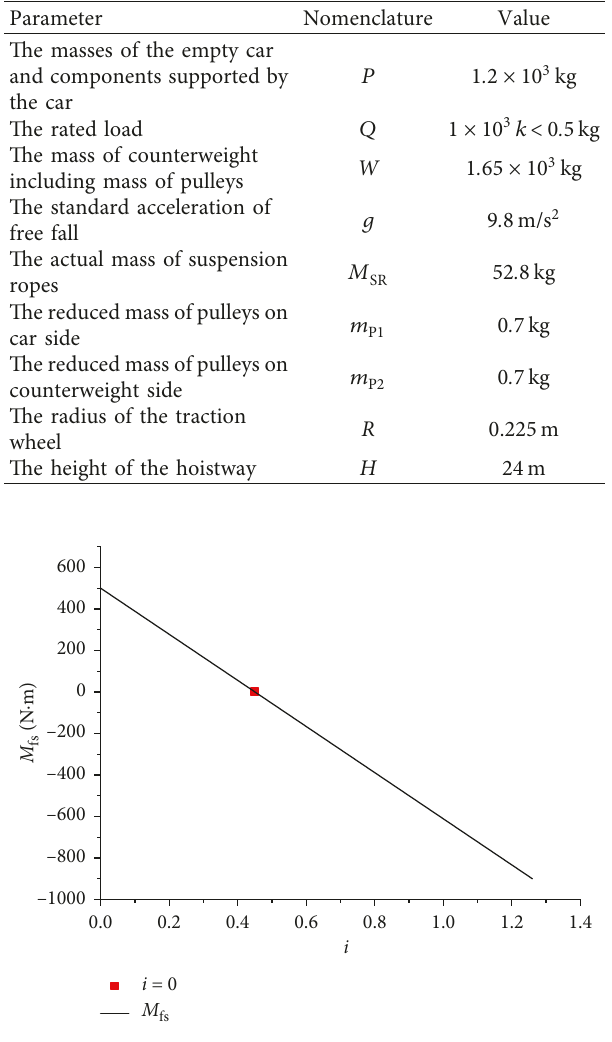
Figure 2: Relation between elevator loading mass ratio and braking torque. Table 2: The influence of car quality on static brake